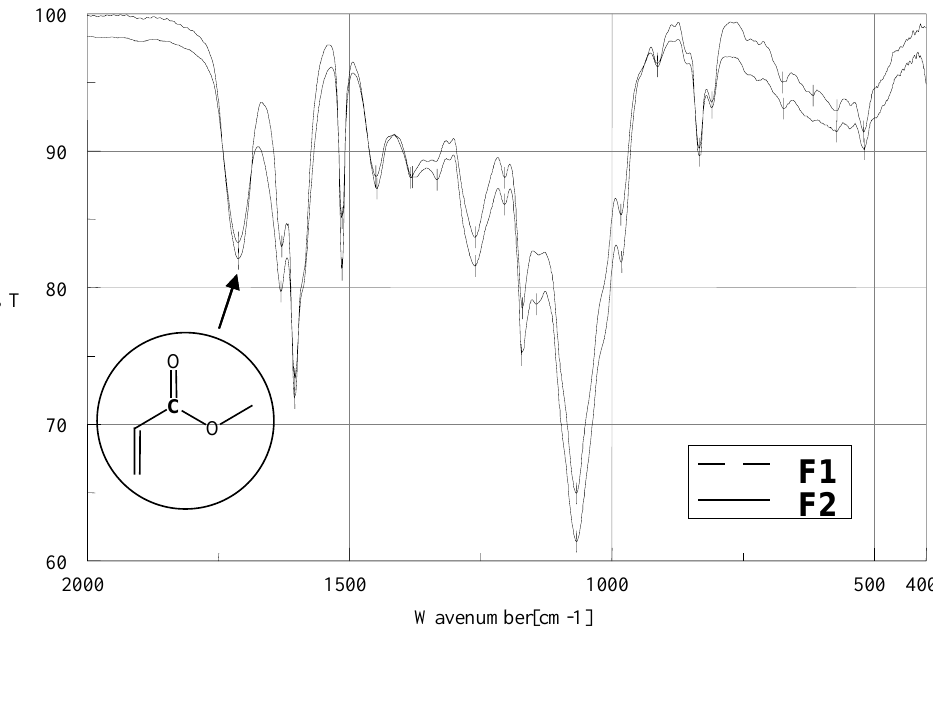
Figure 2. UV spectra of the F1 -Z and F2 -E from fraction F1 obtained with the HPLC DAD detector and FTIR spectra of fractions F1 and F2 , in KBr